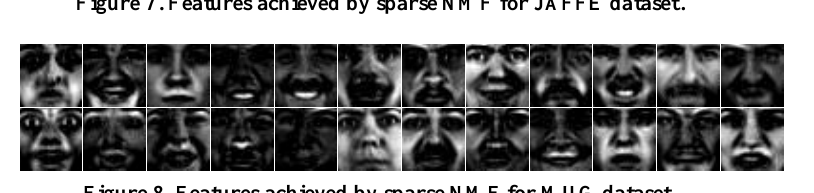
Figure 7. Features achieved by sparse NMF for JAFFE dataset.